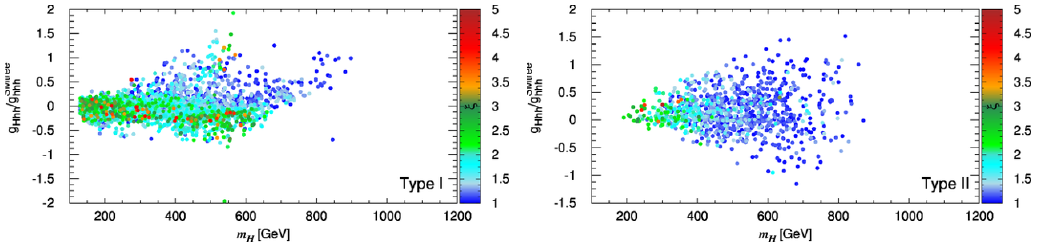
Figure 18 . Triple Higgs coupling Hhh at one-loop level normalized to the SM tree value g SM tree = 3 m 2 =v . In contrast to the hhh coupling, the one-loop corrections to the Hhh cou- hhh h pling are vanishingly small near the alignment limit. To have a better visualization only (cid:24) (cid:21) 1 points are